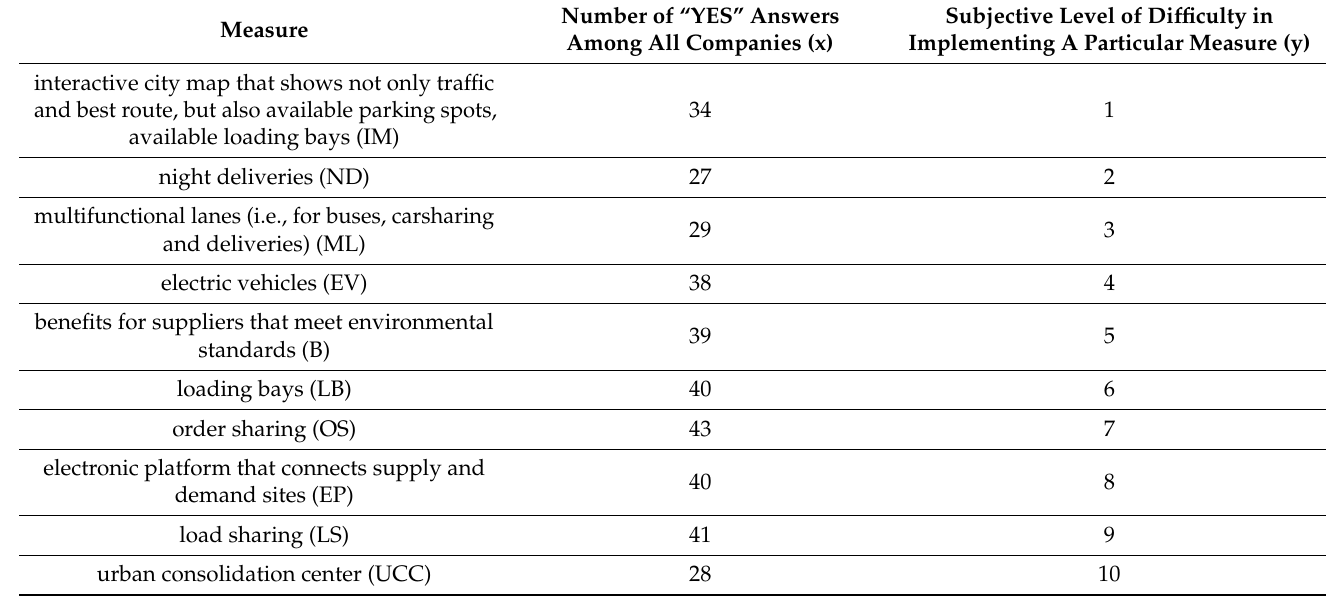
Table 8. Acceptance towards chosen measures among respondents and level of difficulty to imple- ment them.